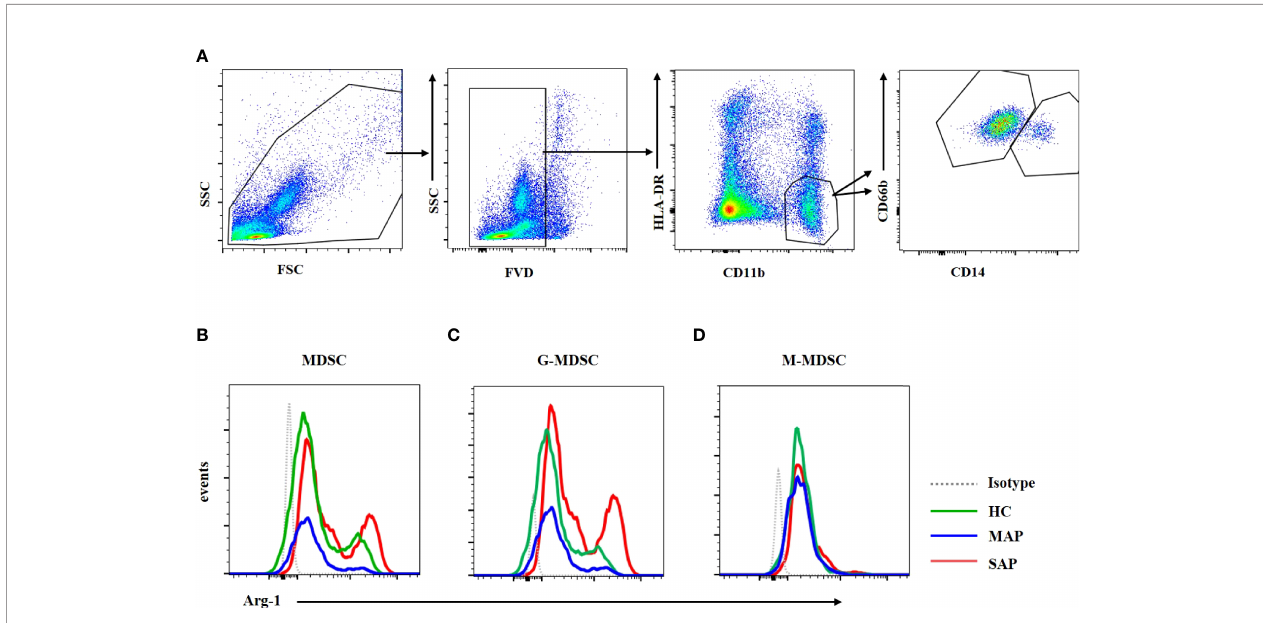
FIGURE 7 | Arg-1 expression in MDSC and G-MDSC was increased in patients with SAP and MAP compared with HCs. (A) The fl ow cytometry pro fi ling of HLA-DR +CD11b+ MDSCs, CD66b+CD14- G-MDSC and CD66b-CD14+ M-MDSC. Arg-1 expression of MDSC (B) and G-MDSC (C) was increased in patients with MAP and SAP. (D) Arg-1 expression in M-MDSC subset from HC, MAP, and SAP had no